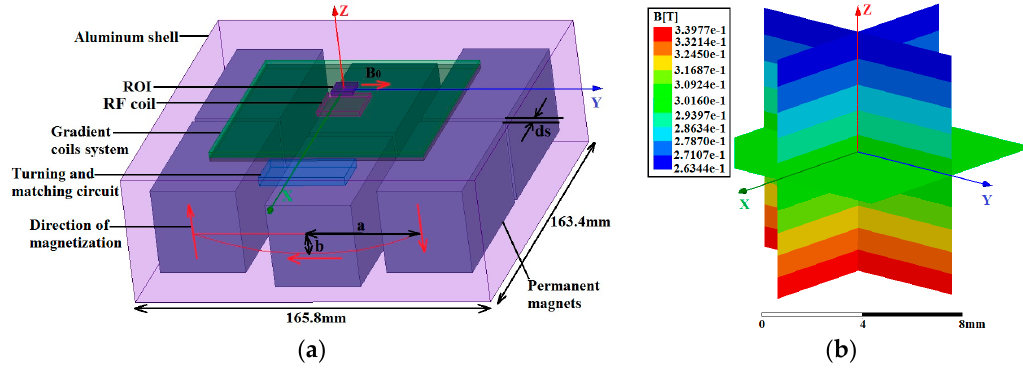
Figure 1. ( a ) Newly reduced Halbach magnet equipped with a 2D gradient coil system. This magnet was created by utilizing six NdFeB magnet blocks. The polarization directions of the magnets and main field are indicated by red arrows. The six magnets are polarized along the − z -, − y -, and + z -directions. The magnets pointing in the same polarization direction were separated by a small gap ds, whereas the magnets pointing to different polarization directions formed a reduced Halbach structure and were positioned in an elliptical arc. The ratio of the semimajor axis a to the semiminor axis b was 2.3. ( b ) Simulation results of the optimized reduced Halbach magnet structure. The magnetic field was computed using the Ansoft finite element method (FEM) software. The calculated magnetic field is shown for distances to the center of the six-magnet array lower than 5 mm and above the magnet array surface at 10–20 mm. At the target plane, the simulated magnetic magnitude was about 0.299 T points along y , and the constant gradient was approximately 7.6 T/m points along z . A homogeneous magnetic field was produced on the horizontal target plane.